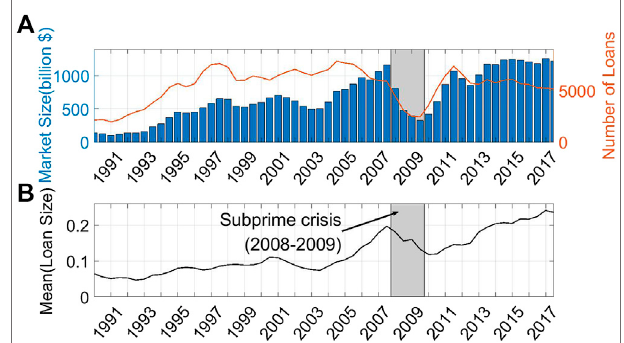
FIGURE 1 | This fi gureisrelatedtothesyndicatedloanmarketintheUnited States from 1990 to 2017. (A) describes market size and the number of loans extended by lead arrangers to borrowers every quarter. Market size is de fi ned as thesumoftheloanamountsextendedbyeachbank.Thenumberofloansis de fi nedasthetotalnumberofloansextendedduringeachquarter. (B) represents the average loan size, which is the market size divided by the number of loans during each quarter. Gray shadows represent recessions as measured as the subprime morgage crisis periods during 2008-2009.